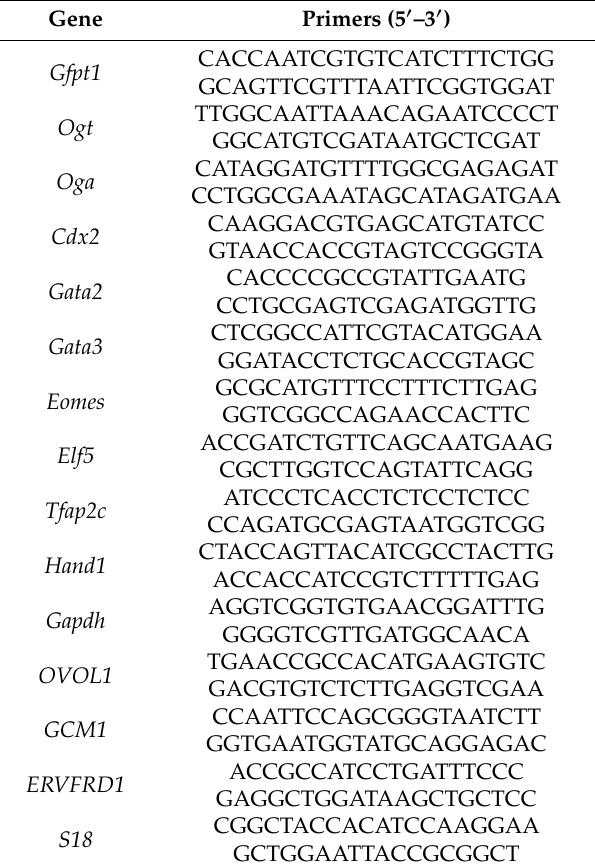
Table 2. Details of PCR primers used in this